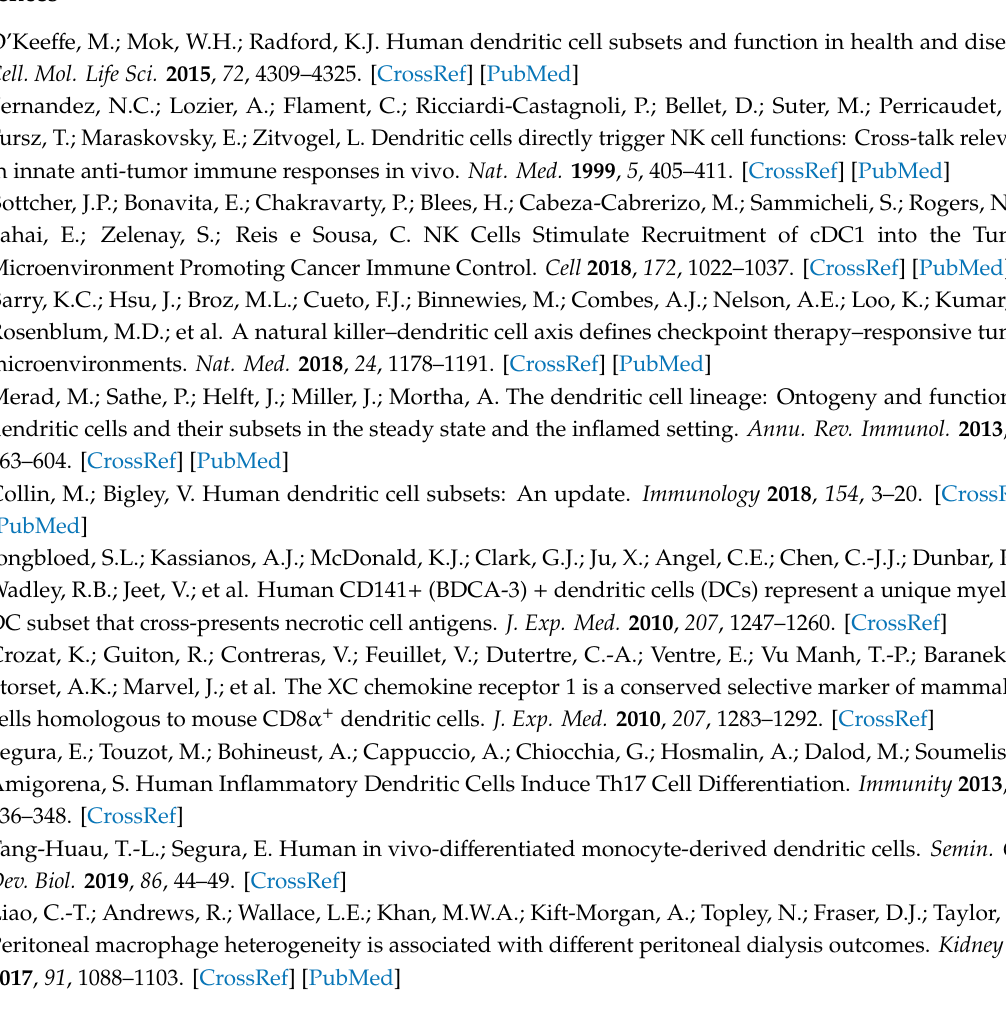
Table S1: Selected clinical trials and preclinical data for ex vivo DC vaccination in